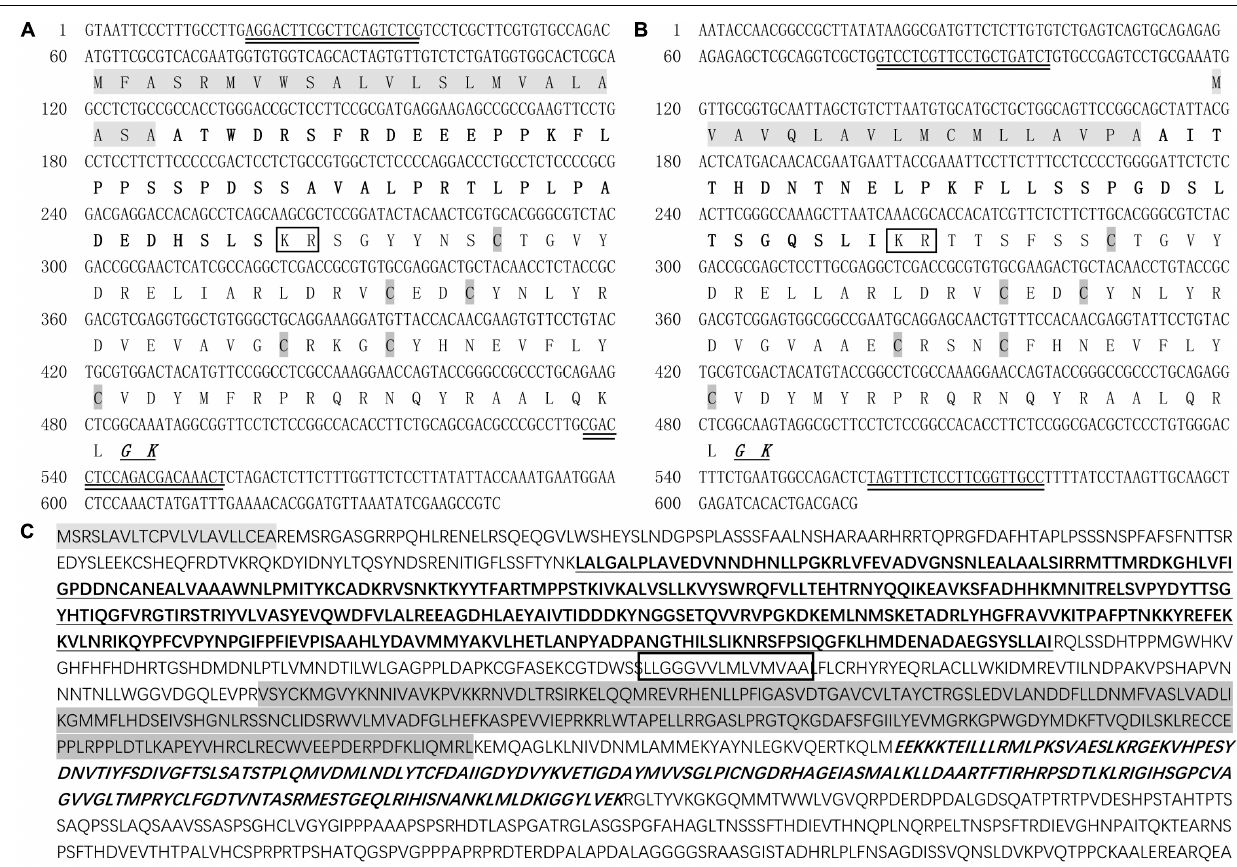
FIGURE 1 | Deduced amino acid sequences and predicted domains of LvCHH1, LvCHH2, and LvGC. (A) Deduced amino acid sequence and predicted domains of LvCHH1. (B) Deduced amino acid sequence and predicted domains of LvCHH2. Signal peptide was showed with light gray box. The CHH-precursor-related peptide was bolded. Dibasic residue cleavage signal (KR) was marked in the box. Amidation signal (GK) was bolded, italic and underline. The conversed cysteine residues were shown as italic with dark gray box. (C) Deduced amino acid sequence and predicted domains of LvGC. Signal peptide was showed in light gray. The receptor domain was bolded and underlined. The transmembrane domain marked in the box. The protein kinase-like domain was showed in dark gray. The guanylate cyclase catalytic domain was bolded and italic. The primers used in RNAi were double underlined.